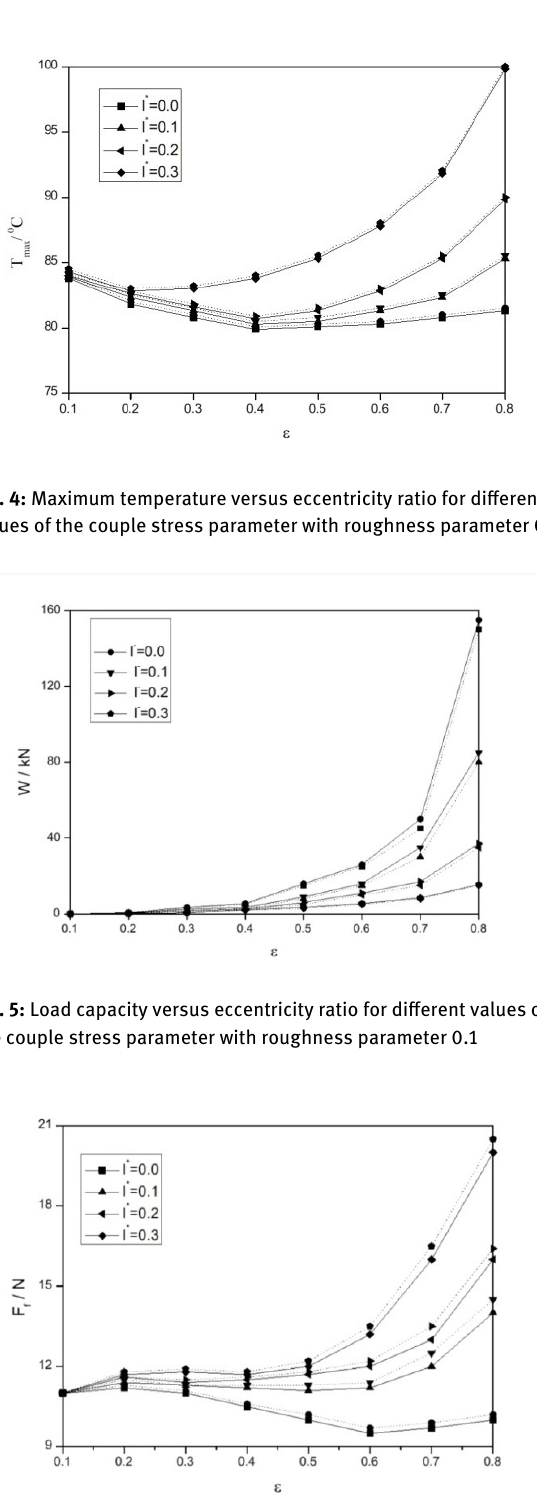
Fig. 6: Friction force versus eccentricity ratio for different values of the couple stress parameter with roughness parameter